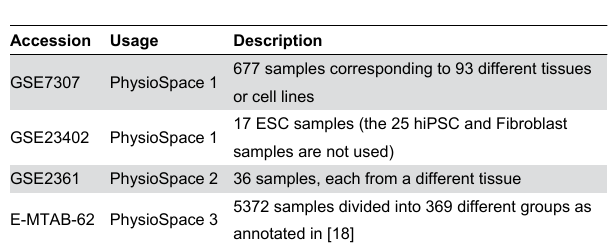
Table 1. Datasets for the PhysioSpace generation. Table 2. Datasets used for